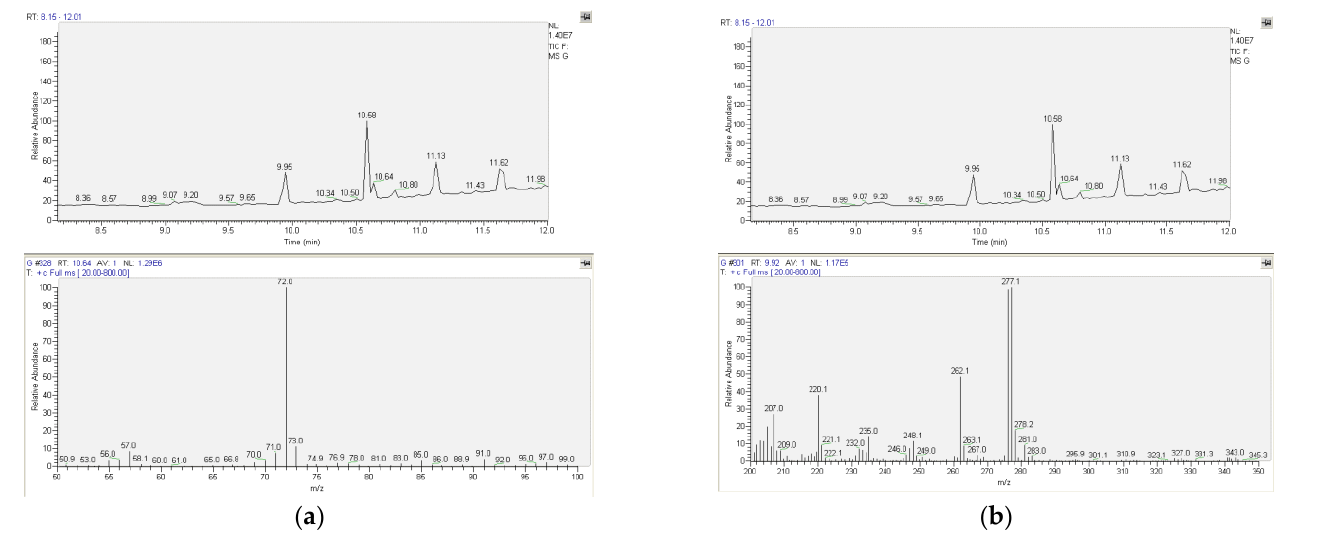
Figure 1. Typical chromatograms and MS spectra for methadone– and EDDP–positive urine samples: ( a ) m ethadone identification in patients’ urine sample – FULL scan (t R = 10.64, m/z = 72), Patient 7; ( b ) EDDP identification in patients’ urine sample – FULL scan (t R = 9.92, m/z = 277), Patient 7.